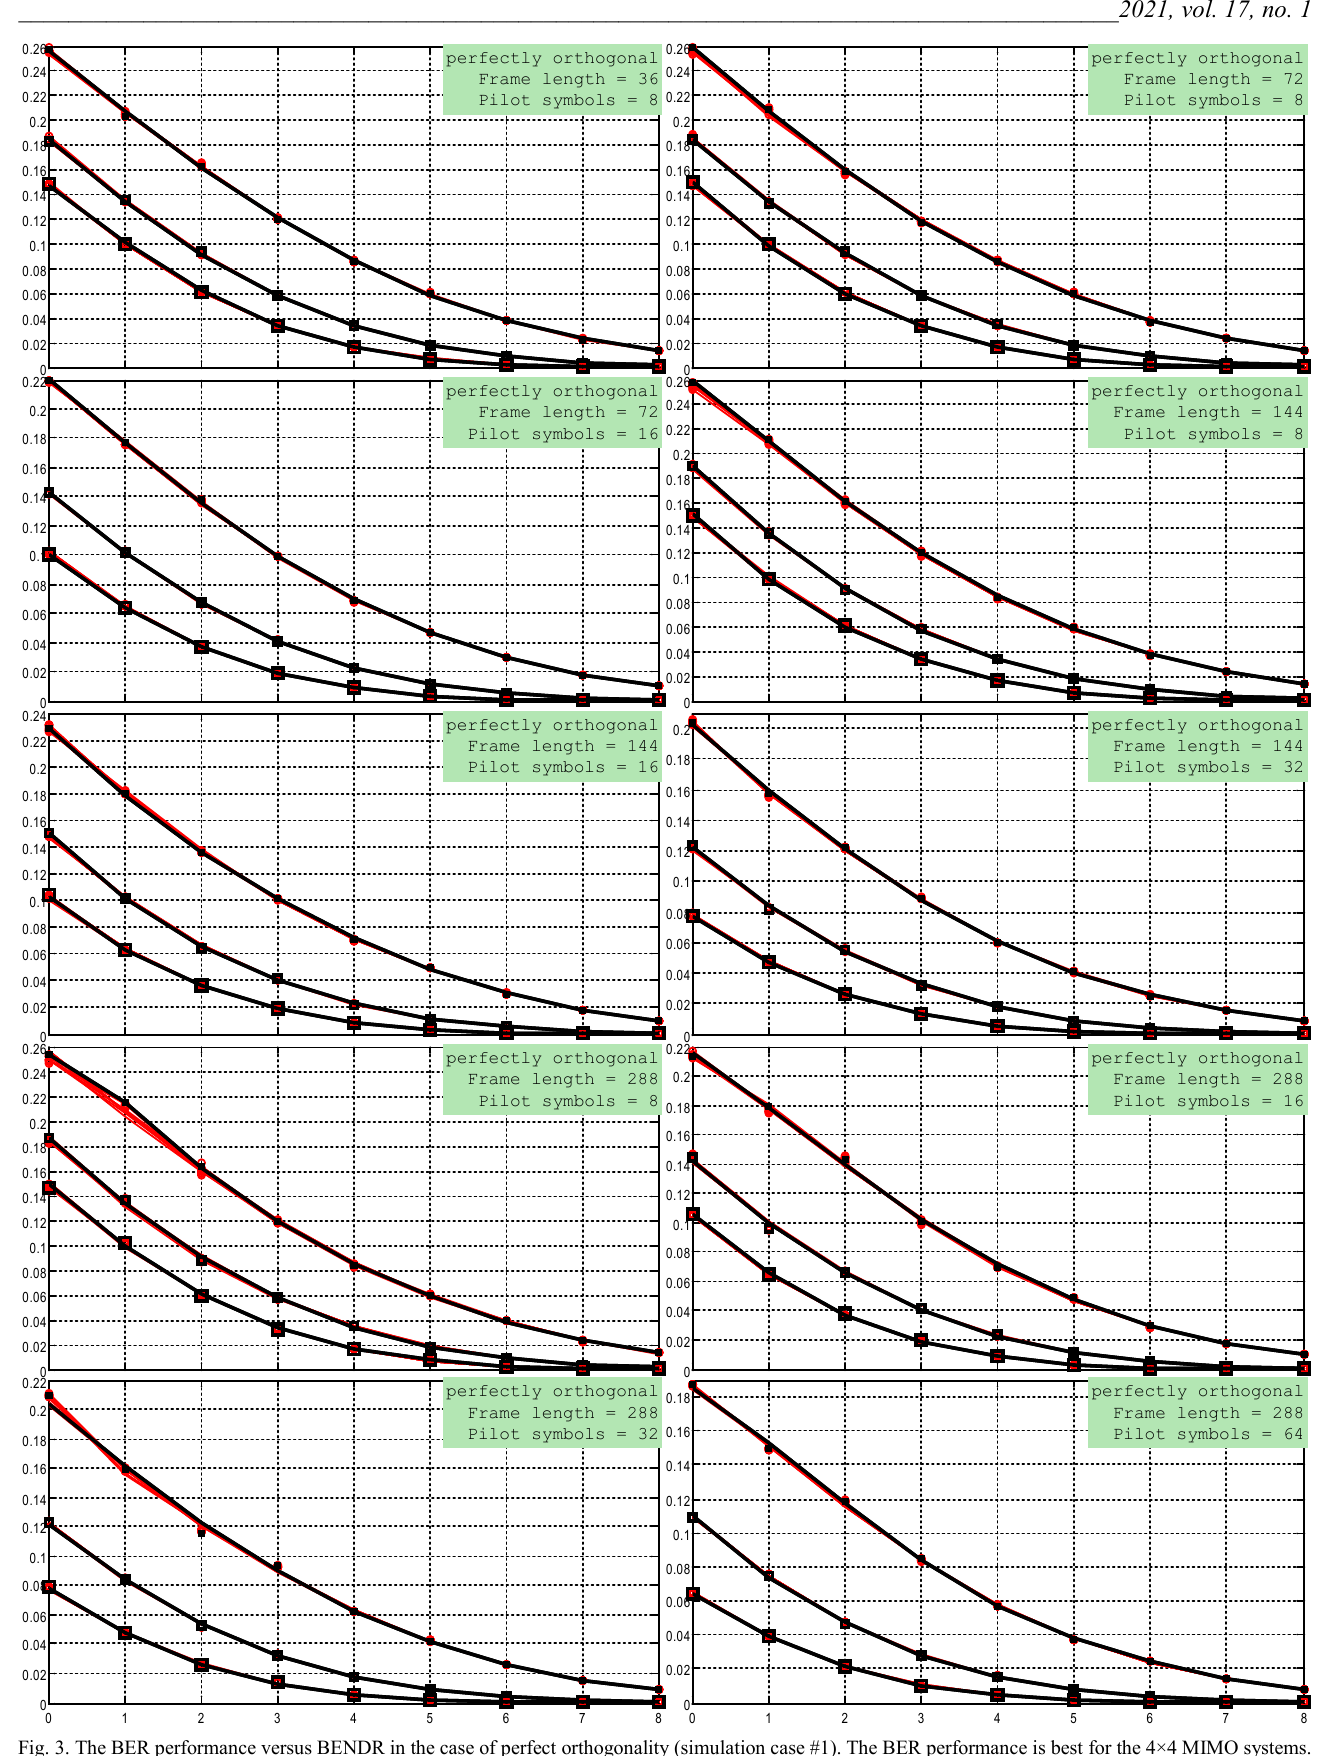
Fig. 3. The BER performance versus BENDR in the case of perfect orthogonality (simulation case #1). The BER performance is best for the 4×4 MIMO